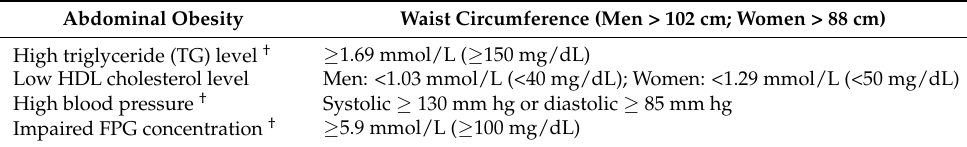
Table 1. Criteria used for the diagnosis of the metabolic syndrome criteria (NCEP-ATPIII). Abdominal